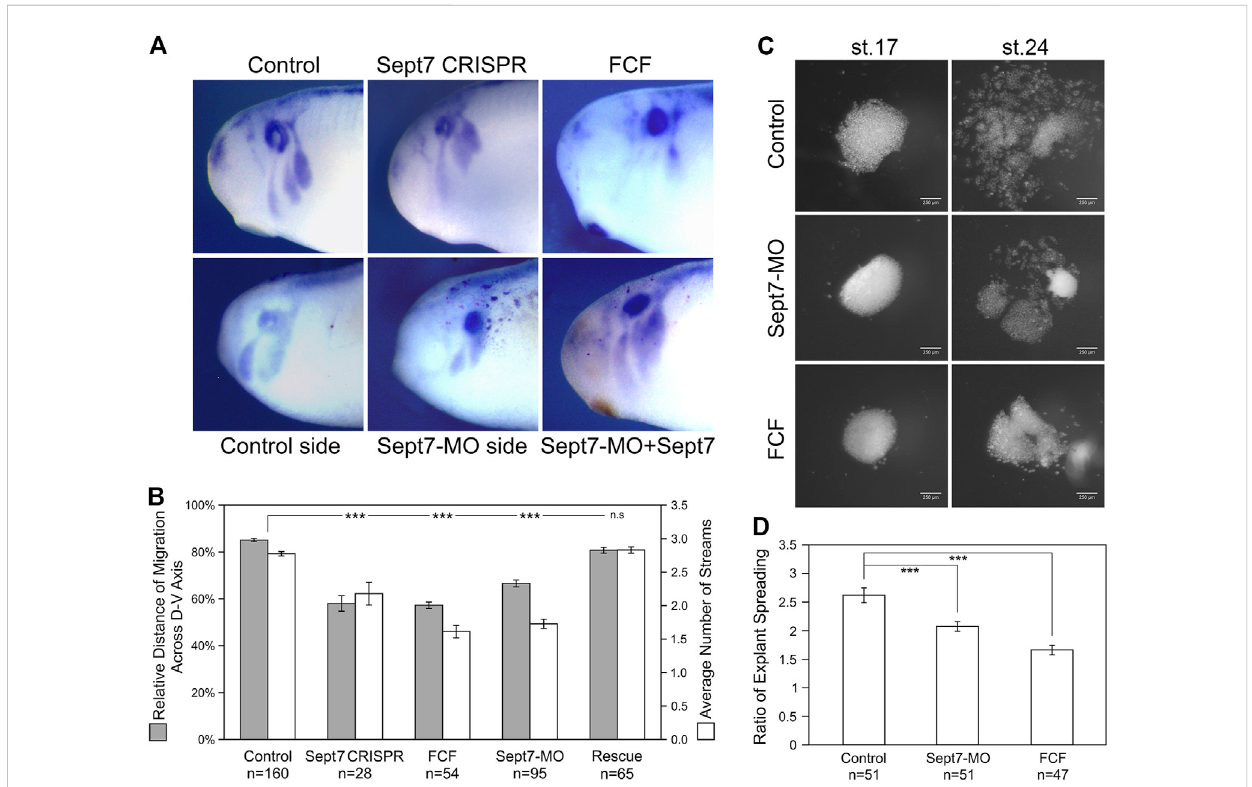
FIGURE 1 Loss of septin fi laments leads to defective neural crest cell migration. (A) Sox10 in situ hybridization on untreated and experimental embryos. Septin inhibition by CRISPR-mediated genome editing on Septin7, Septin7 translation blocking morpholino (10 ng), and septin inhibitor forchlorfenuron (FCF, 200 µM) all led to obvious defects in neural crest cell migration. Septin7 RNA can rescue neural crest migration defects caused by Septin7-MO. Septin7- MO and RNA were co-injected into one side of the cleavage stage embryos together with the lineage tracer nuclear beta-Gal, which was detected by enzymatic reactions (shown as dark red dots). (B) Relative distance of cranial neural crest cell migration across the dorsal-ventral axis of the embryo and the number of migratory streams were measured/counted and plotted. Septin7 CRISPR, Septin7-MO, and FCF treatment all led to a signi fi cant reduction inthemigrationdistanceandthenumberofmigratory streams. Septin7rescuedthemigration defects effectively. (C) Spreading ofneuralcrest explants on fi bronectin. Images were taken 2 and 16 h after dissection (around stage 17 and 24). (D) The degree of explant spreading was calculated by comparing the area of explants at the early and late stages. Both Septin7-MO and FCF decreased the ratio of explant spreading signi fi cantly. 2-tailed Student ’ s t -test was performed. *** stands for p < 0.001. Error bars indicate standard error of the